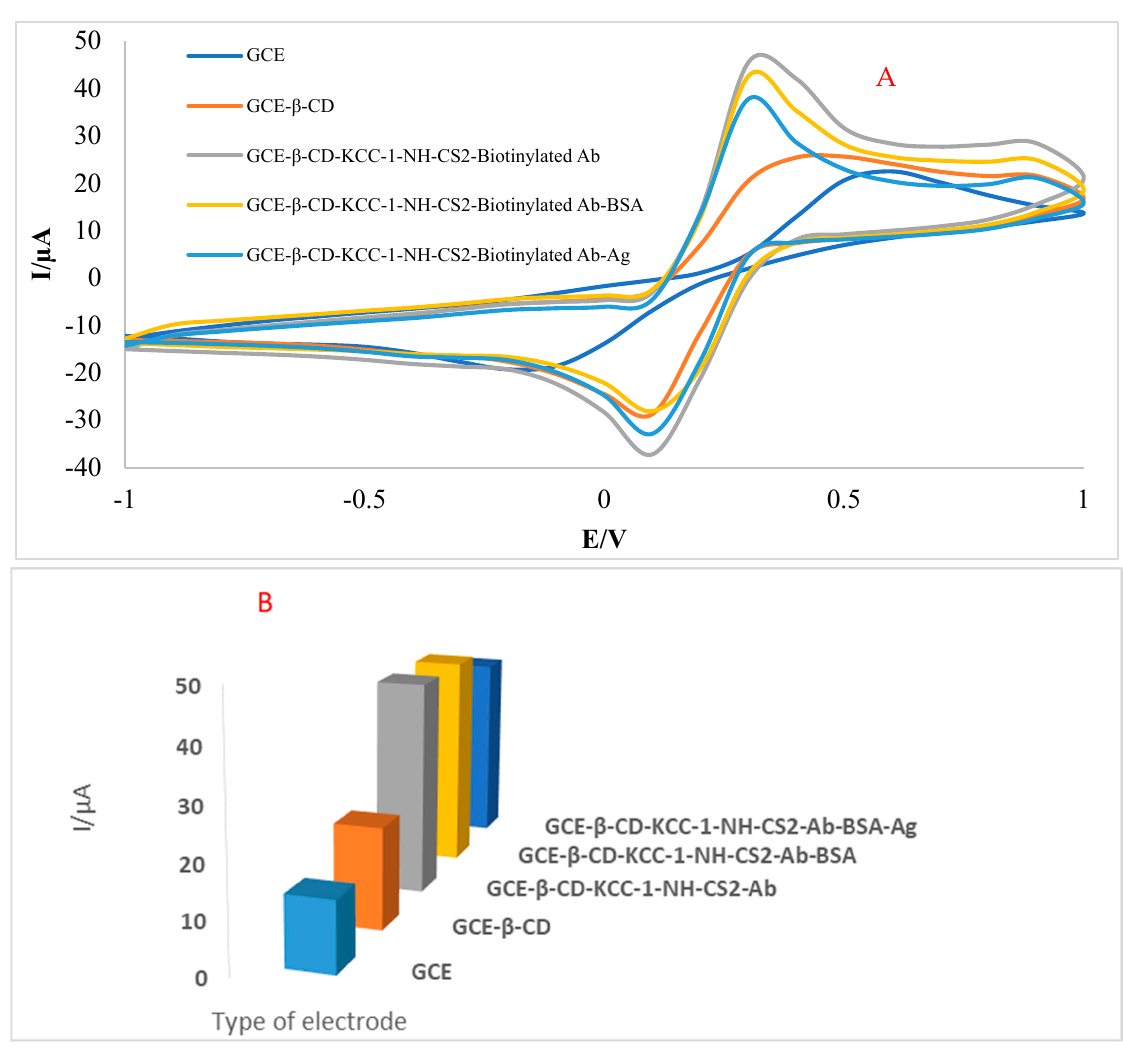
Figure 1. ( A ) CV characterization of step-by-step fabrication of immunosensor, the supporting electrolyte was 0.05 M solution [Fe (CN) 6 ] 3 − /4 − /KCl with a potential range from − 1 to 1, scan rate = 0.1 V/s. ( B ) Comparison of peak currents recorded in the process of immunosensor fabrication. Table 1. Peak currents and peak positions of GCE and modified GCEs in the process of immunosensor fabrication.